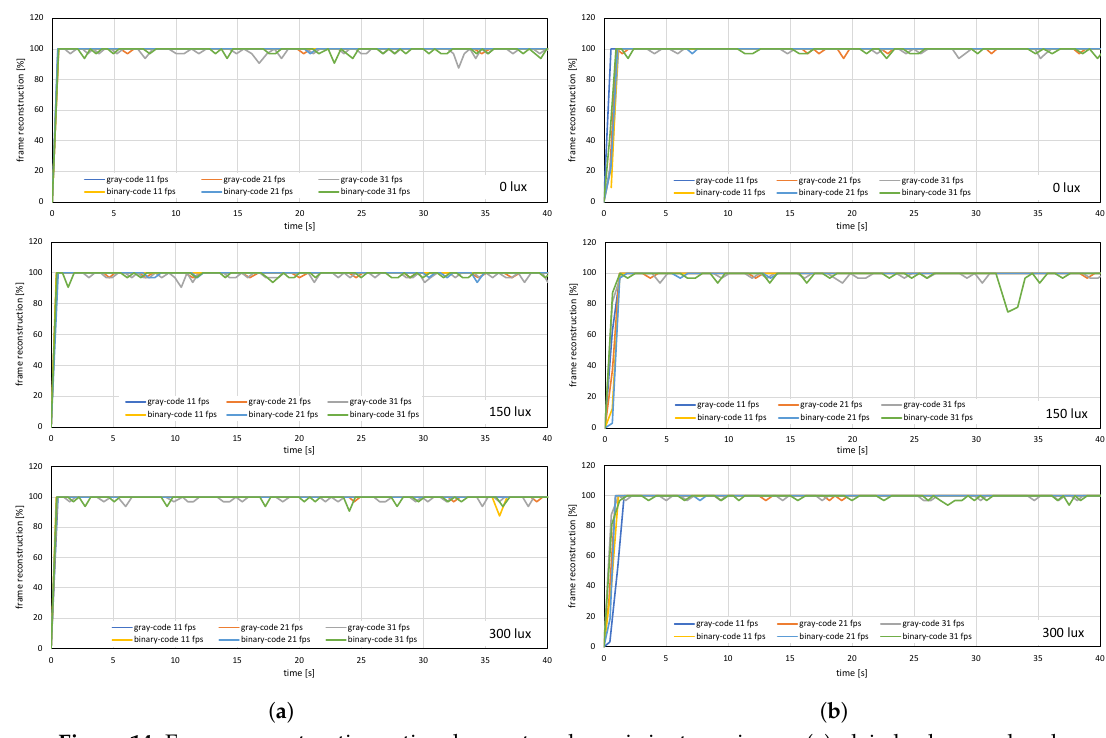
Figure 14. Frame reconstruction ratio when a stored movie is streaming on ( a ) plain background and ( b ) patterned background.